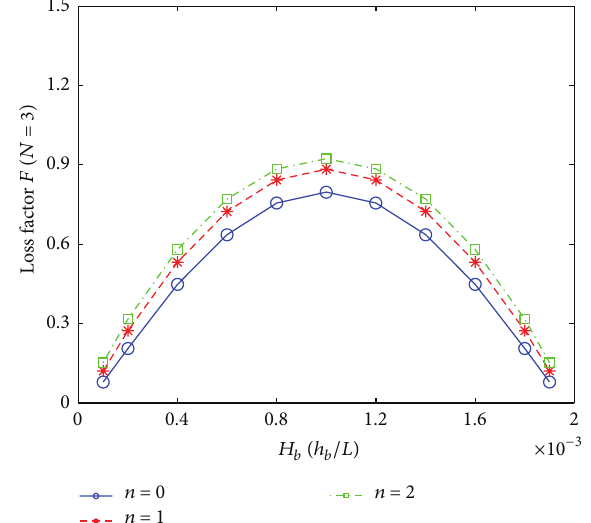
Figure 17: Optimized loss factor results for different CLD configu- rations ( 𝐻 𝑏 + 𝐻 𝑐 = 0.002 ).